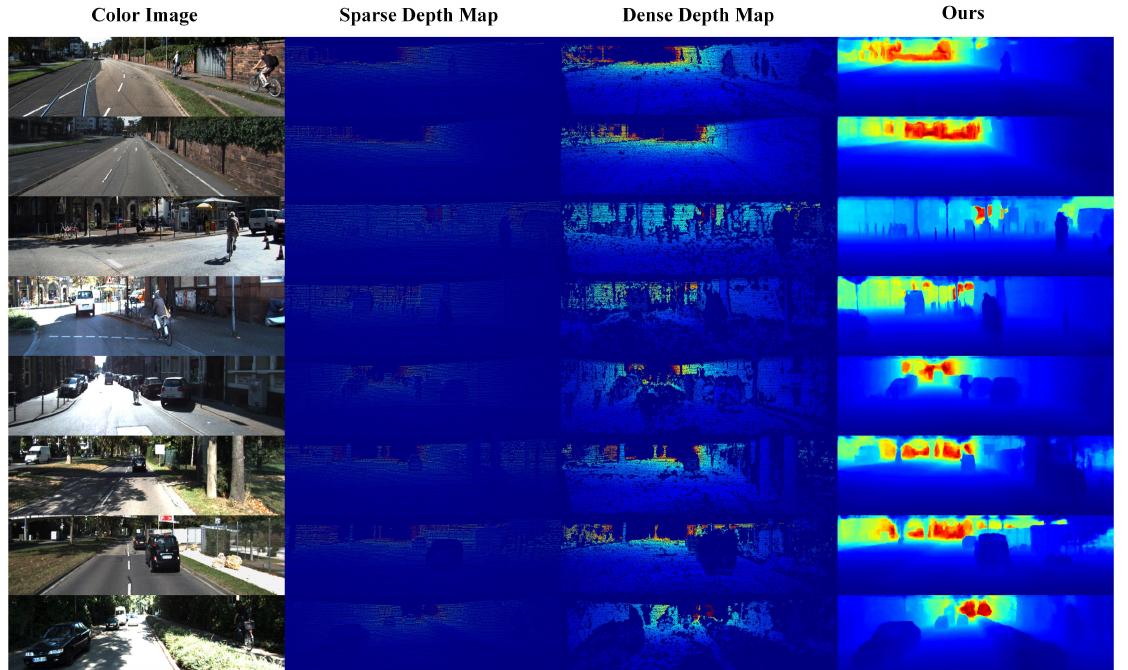
Figure 3. Results of interpolated depth map obtained by PLIN. From left to right, the color image as input is depicted in the first column. In column 2 the sparse depth map corresponding to the color image is presented, in column 3 the dense depth map represents the ground truth of network